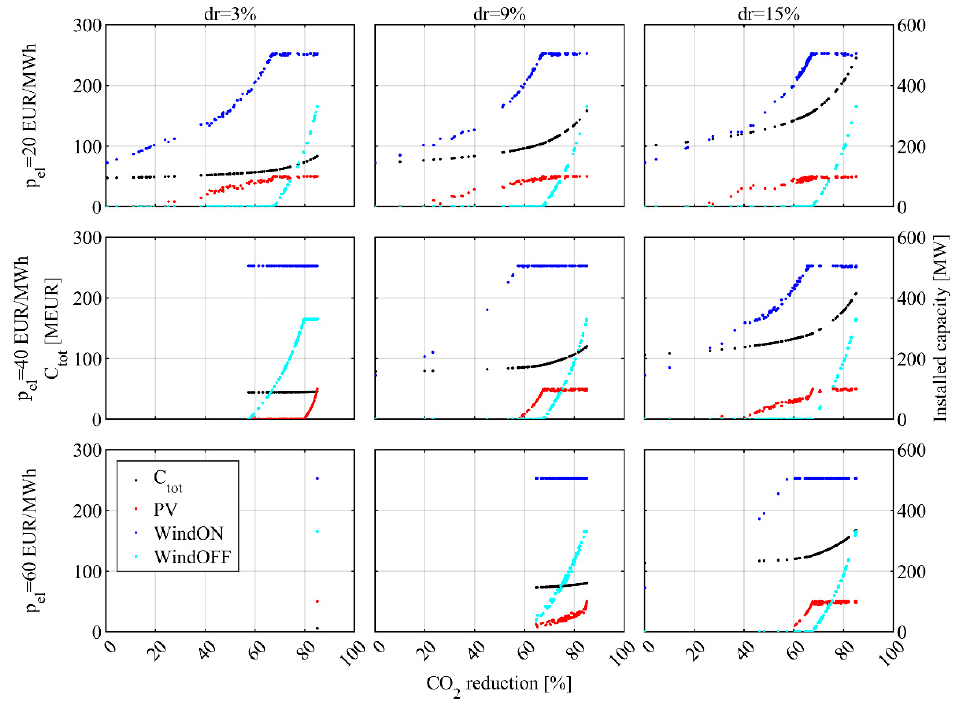
Figure 3. Electricity sector, optimal results with three decision variables (PV, WindON and WindOFF), sensitivity analysis for p el and dr .